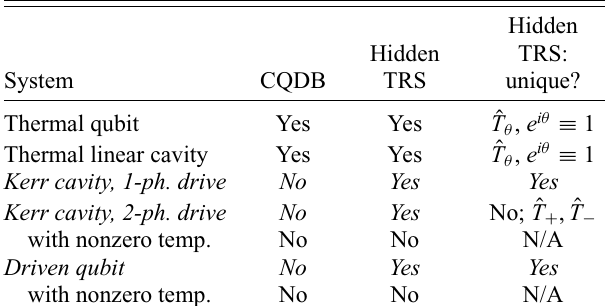
TABLE I. Common driven-dissipative quantum systems and their status both with respect to CQDB (cf. Sec. II D), and our new notion of hidden TRS. Italics indicate systems with hidden TRS that do not have CQDB. Some of these systems possess multiple distinct hidden TRS (rightmost